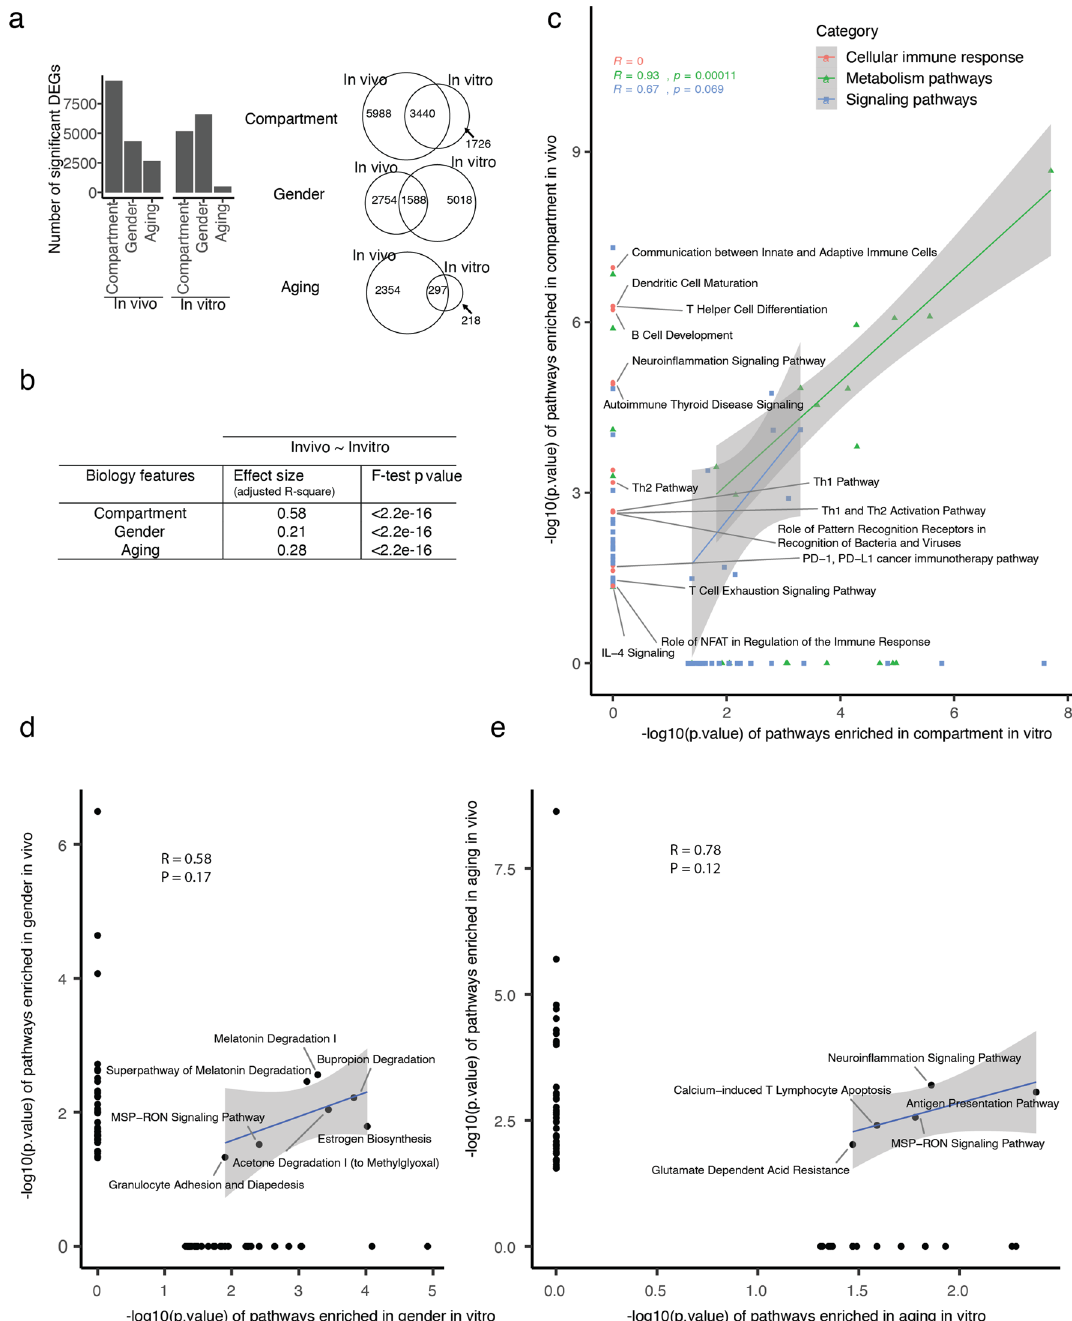
Figure 3. Meta-analysis on specific biology features (compartment, gender, aging) respectively revealed how biology features changed in culture. ( a ) Bar charts indicating the number of significantly differentially expressed genes (DEGs) found in different conditions (compartment, gender, aging) from in vivo and in vitro (left panel). Venn diagrams of the DEGs in the indicated conditions as in the left panel between in vivo and in vitro. ( b ) Table of effect size of in vitro representing in vivo defined by simple linear regression model. Effect size was defined by the adjusted coefficient of determination (adjusted R 2 ) of the linear model. F-test p-value was used to evaluate the linear model on our data. ( c – e ) Scatter plot between in vivo and in vitro on the enriched pathways in different conditions: compartment ( c ), gender ( d ) and aging ( e ), indicating most biology features got lost after culture. Pathways clustered together were summarized in super categories. Coefficient (R) and p-value were calculated by method of “pearson” correlation. See also Supplementary Figs.